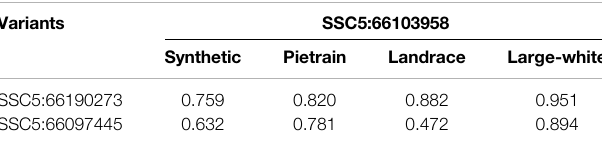
TABLE 9 | LD (r2) between the lead SNP SSC5:66103958 and the other variants SSC5:66190273 and